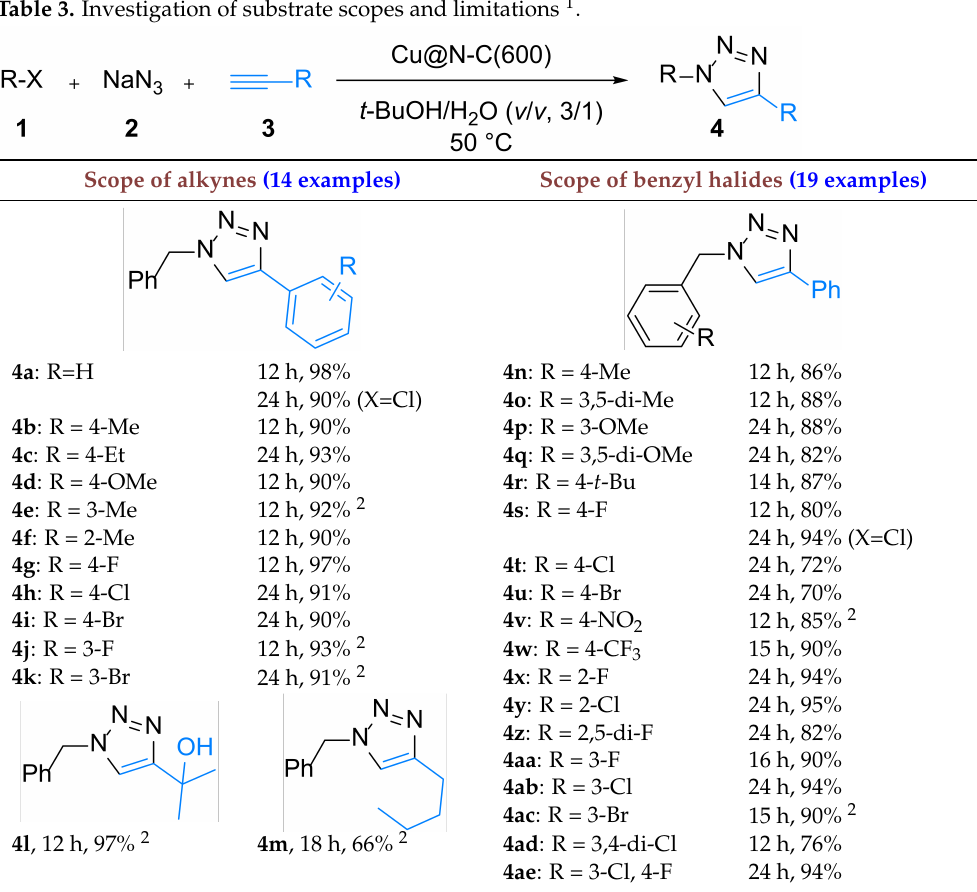
Table 3. Investigation of substrate scopes and limitations 1